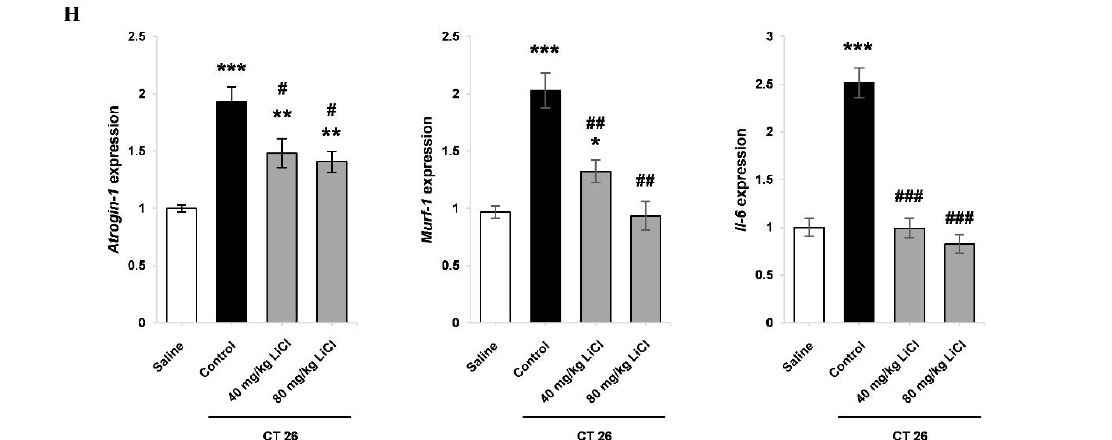
Figure 7. LiCl ameliorates muscle wasting in a mouse model of cancer cachexia. Male BALB/c mice were treated as follows: (1) no treatment, (2) transplantation with CT26 colon carcinoma cells, (3) transplantation with CT26 cells and treatment with 40 mg/kg LiCl, and (4) transplantation with CT26 cells and treatment with 80 mg/kg LiCl. ( A ) Dissected tumor mass. ( B ) Tumor free body weight. ( C ) Quadriceps and tibialis anterior muscle weight/body weight (mg/BW) ratio. ( D ) Gonadal adipose tissue mass for ( A – D ) n = 5 at 28 days post-transplantation. ( E ) Grip strength at 21 days post-transplantation (n = 5). ( F ) Average fiber cross-sectional area of quadriceps (n = 4). ( G ) Representative H&E staining images of the quadriceps (scale bar = 100 µm). ( H ) qPCR analysis of Atrogin-1, Murf-1, and Il-6 expression in quadriceps muscle (n = 4). Significant difference compared to saline is indicated by* (* = p -value < 0.05, ** = p -value < 0.01, *** = p -value < 0.001). Significant difference compared to CT26 control is indicated by# (# = p -value < 0.05, ## = p -value < 0.01, ### = p -value <